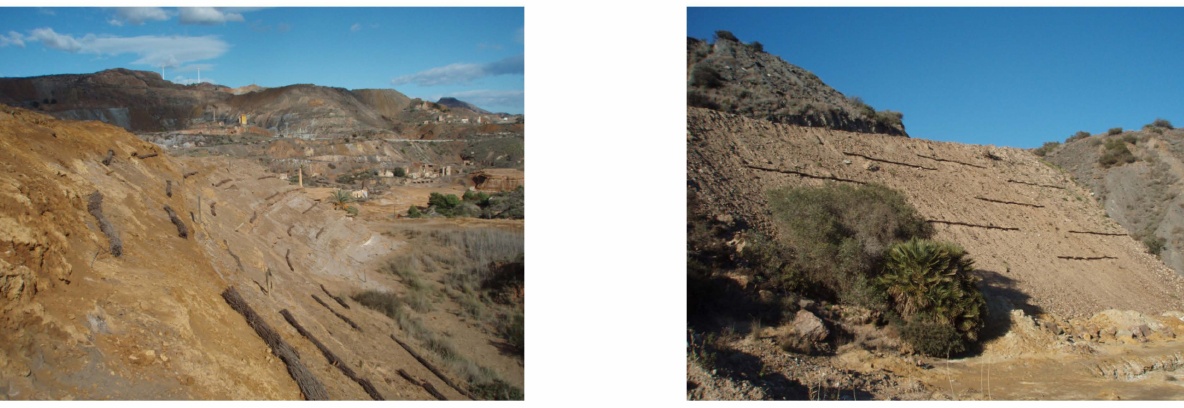
Figure A11. Detail of stabilization of slopes with heather sashes in Case Study